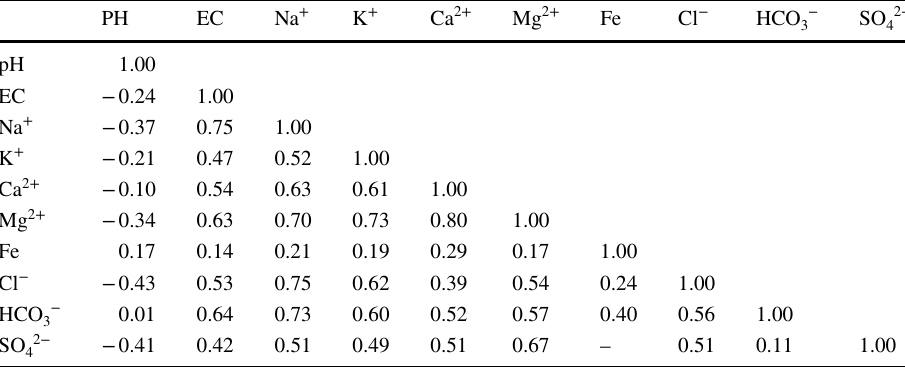
Table 3 Correlation coefficient matrix of groundwater quality parameters ( n =